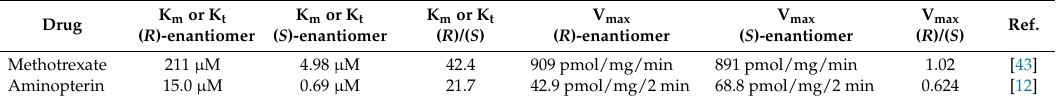
Table 1. Kinetic parameters of the PCFT-mediated transport of methotrexate and aminopterin. K m or K t Drug ( R